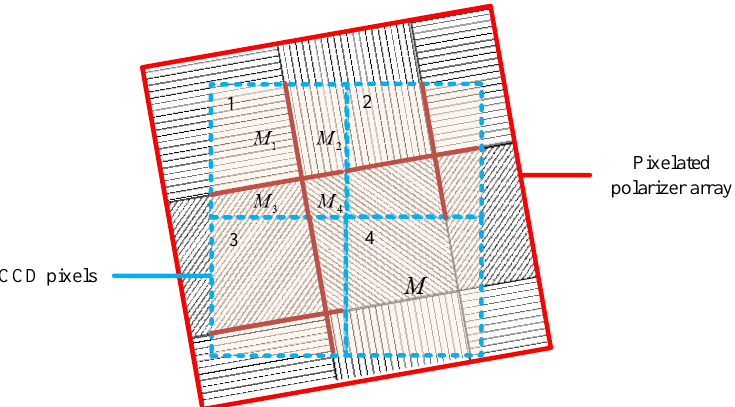
Figure 5. Schematic representation of the installation error of pixelated polarizer